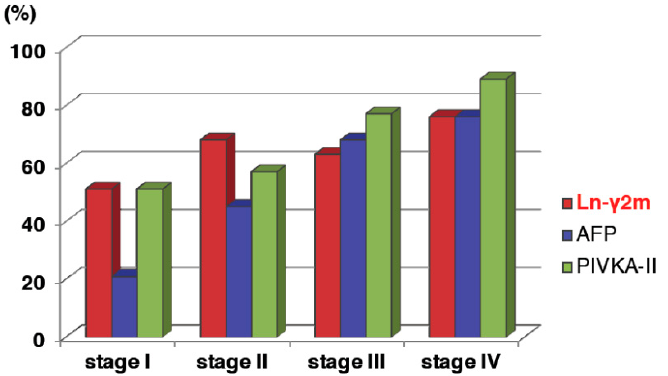
Figure 8. Serum monomeric Ln- γ 2 levels were measured in 57 patients with HCC. HCC positive rates, obtained when combining two biomarkers, were compared. Three patients were negative for all three biomarkers. HCC detection rates for the combination of Ln- γ 2 and PIVKA-II, Ln- γ 2 and AFP, and PIVKA-II and AFP, were 89.5% (51/57), 82.5% (47/57), and 80.7% (46/57), respectively. A combination of all three markers was detected in 54/57 patients (94.7%). Figure 8 is modified from Kiyokawa et al. [22].